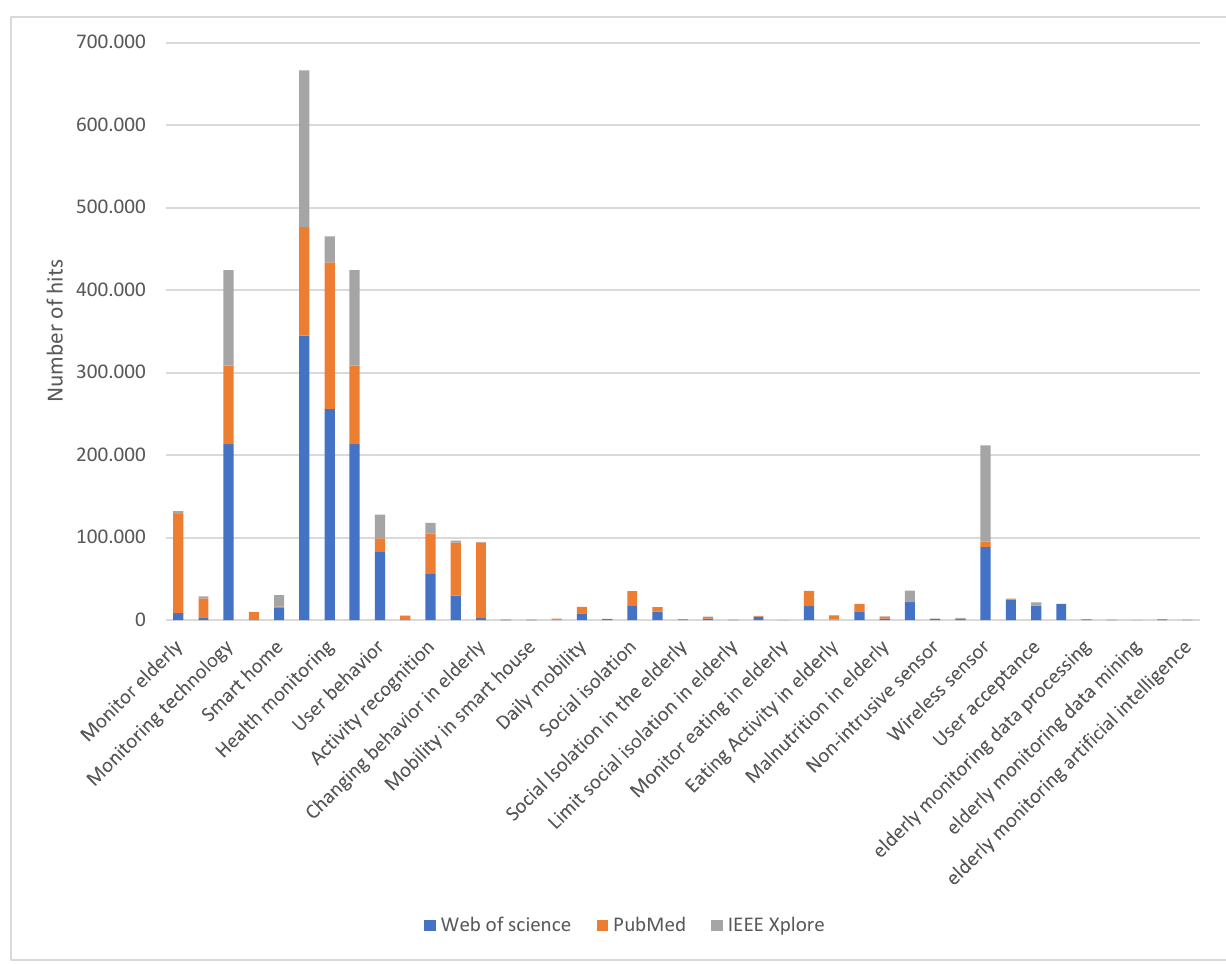
Figure 1. Number of hits in the field of research on elderly monitoring systems between 2010 and 2020.